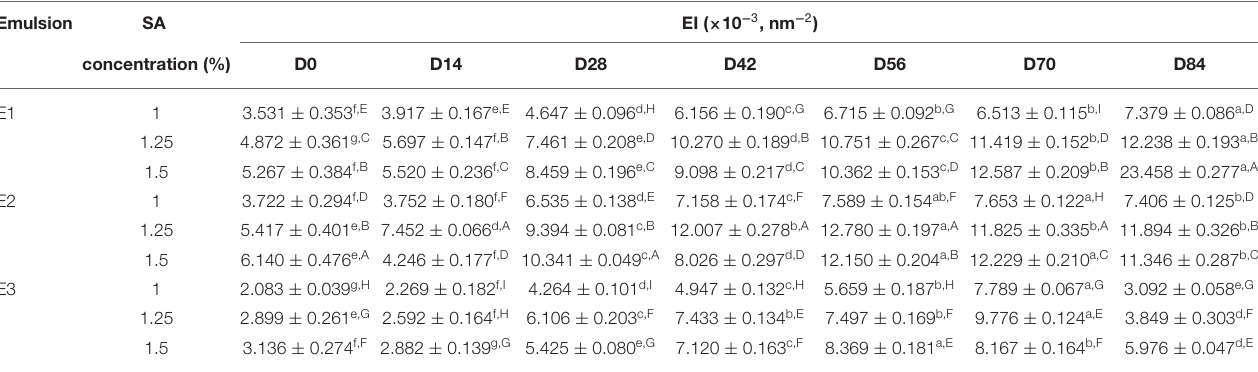
TABLE 3 | Elasticity index of E1, E2, and E3 emulsions under different storage times. Emulsion